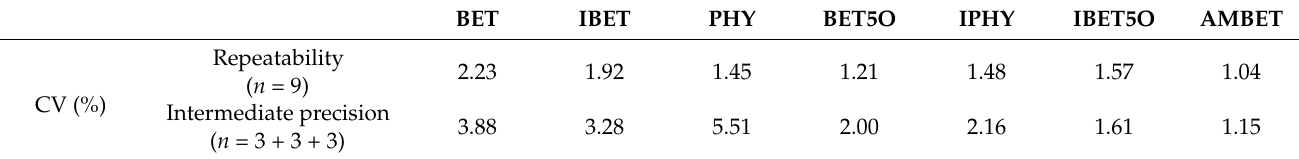
Table 4. Repeatability and intermediate precision of the developed